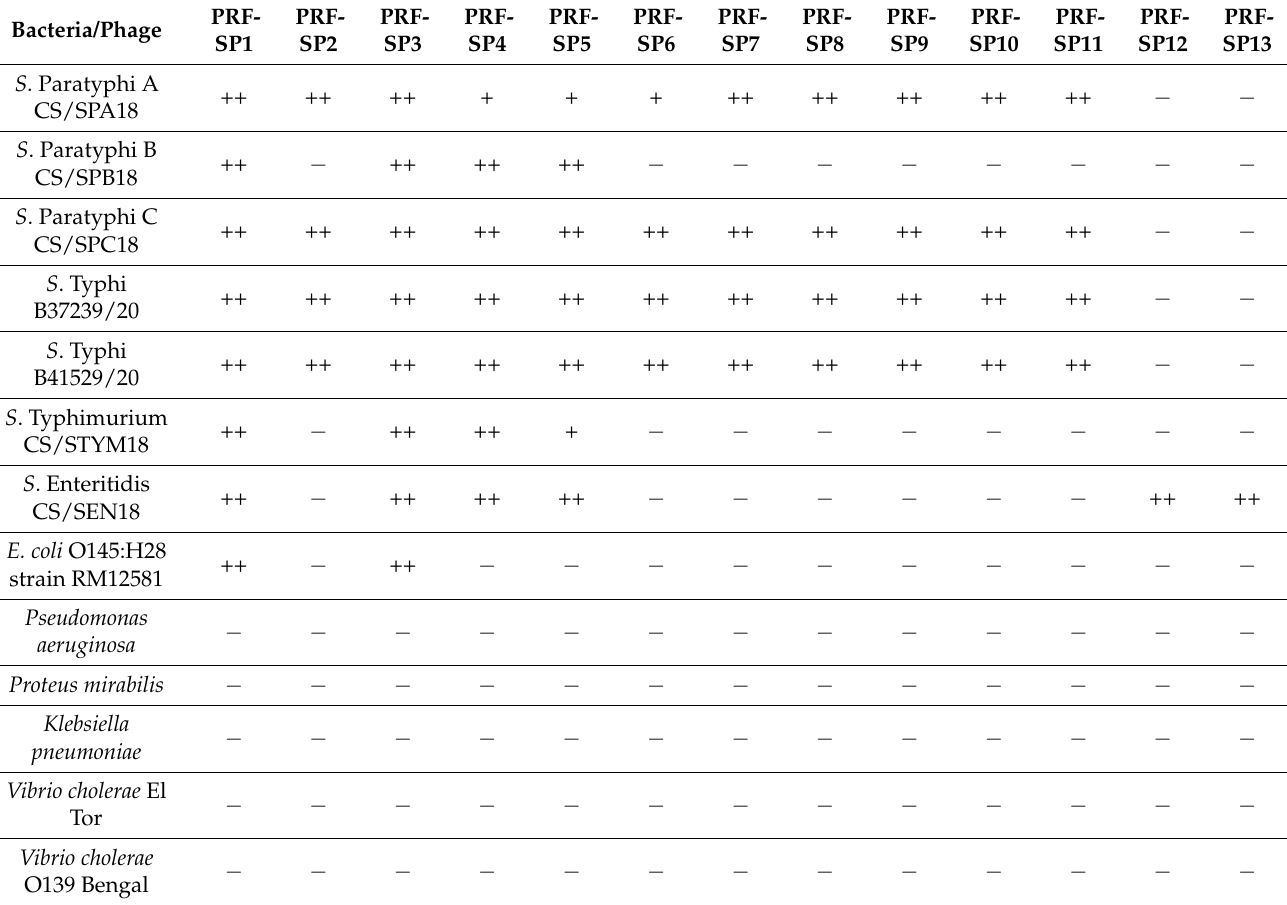
Table 1. Host ranges of the phages. ++ = Clear lysis, + = Turbid lysis, − = No lysis.